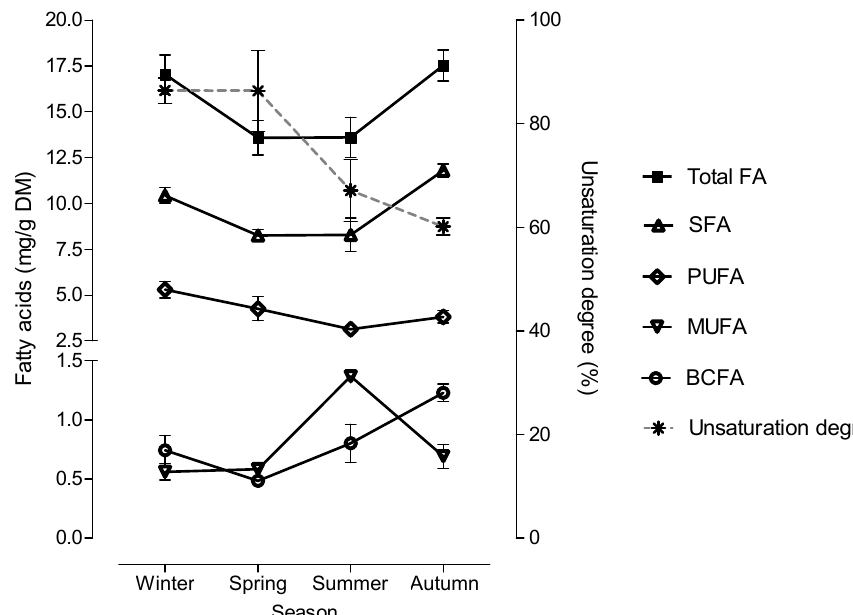
Figure 4. Variation in total fatty acids (FA), saturated fatty acids (SFA), polyunsaturated fatty acids (PUFA), monounsaturated fatty acids (MUFA), branched-chain fatty acids (BCFA) concentration and unsaturation degree in leaves according to season, unsaturation degree = (% monoenoic fatty acids × 1) + (% dienoic fatty acids × 2) + (% trienoic fatty acids × 3).